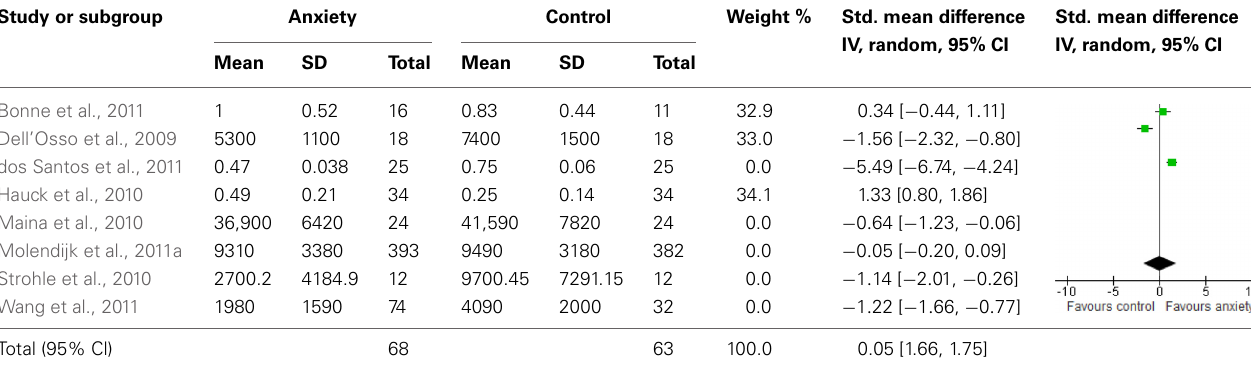
Table 6 | Subgroup analysis: PTSD studies. Study or subgroup